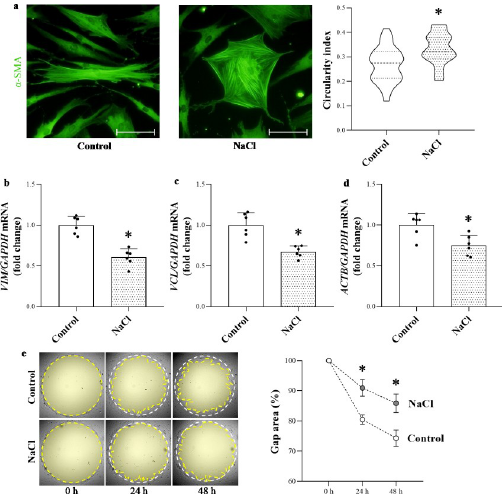
Fig 4. Effect of high NaCl concentration on human primary dermal fibroblast cells. ( a ) Cellular morphology of the cells was visualized by α -SMA immunofluorescent staining (green). Scale bar: 20 μ m ( a ) Determination of circularity of α -SMA immunopositive human primary dermal fibroblasts was carried out by graphical analysis of the cells (n = 35–40). Values were expressed as mean+SD. � p < 0.05 vs. Control (Unpaired t-test). ( b-d ) The mRNA expression of cell motility markers VIM , VCL and ACTB in the human dermal fibroblasts was determined by real-time PCR in comparison with GAPDH . Data were normalized and presented as the ratio of the mean values of the control group. Values were expressed as mean+SD. Dots represent individual values (n = 6). � p < 0.05 vs. Control; (Unpaired t-test (b, c), Mann-Whitney U-test (d)). ( e ) The migration of DFs was determined by measuring the size of the cell-free gap area at 0, 24 and 48 hours (n = 8). Values were expressed as mean+SD. � p < 0.05 vs. Control (two-way ANOVA + Sidak’s multiple comparison).